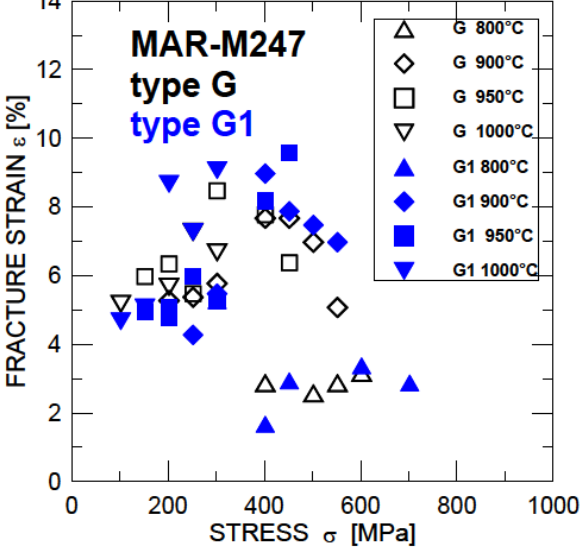
Figure 13: Monkman-Grant relationship for different temperatures for the G